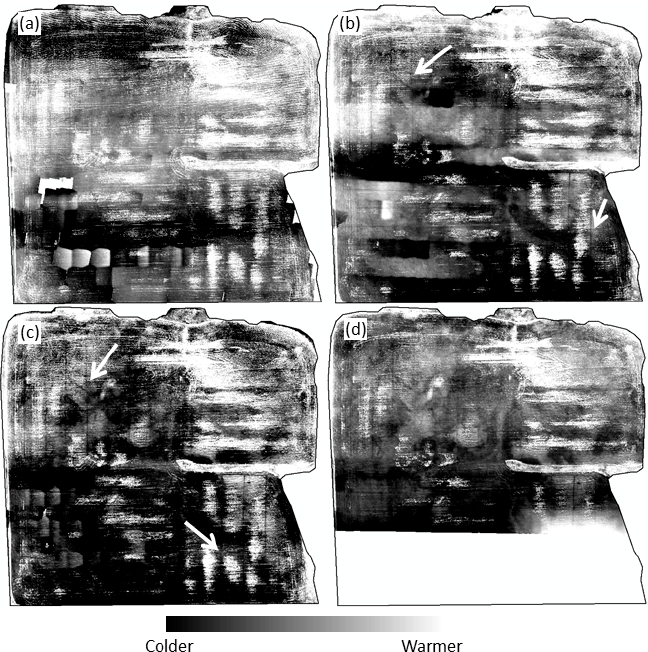
Figure 6. Thermal maps derived from radiometric thermal images collected at different days: ( a ) dry condition, on 22 July 2019, ( b ) After rainfall, on 29 July 2019, ( c ) After rainfall, on 30 July 2019 and ( d ) rain in the morning, on 6 August 2019. The actual ground temperature varies between 30 °C to 45 °C. The white arrows are showing the dark lower-temperature line running parallel to the tile lines.